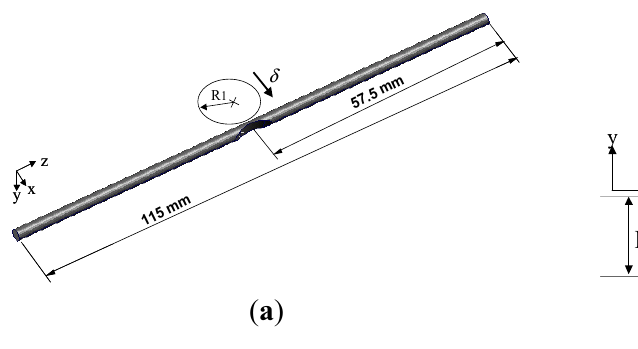
Figure 2. Geometrical model of grooved POF specimen. ( a ) Gauge length of POF specimen with grooved section located at mid-point position. ( b ) Enlarged view of groove geometry.